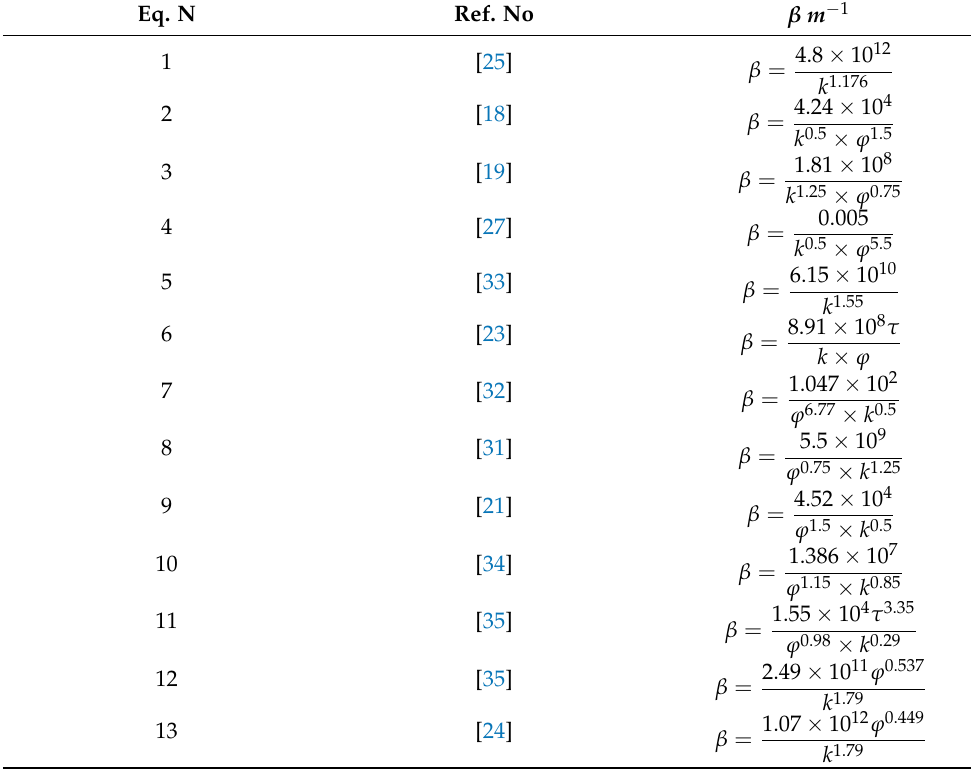
Table 1. Non-Darcy coefficient β